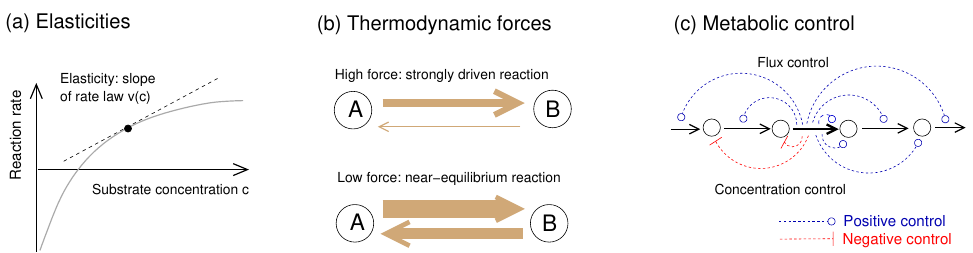
Figure 1. Metabolic rate laws and dynamics: elasticities, thermodynamic forces, and metabolic control. ( a ) A reaction rate depends on metabolite concentrations as described by a rate law v ( e , c ) . The slope ∂ v / ∂ c is called reaction elasticity. ( b ) In strongly driven reactions, with a driving force (cid:29) 1, the net rate is dominated by the forward rate and the product elasticity is almost θ = ln v + v − zero. In contrast, close to chemical equilibrium (with a driving force θ ≈ 0 and large forward and ∂ v l = c i backward rates, but a small net rate), the scaled elasticities ˆE v l c are large. ( c ) Metabolic v l ∂ c i i control coefficients describe how perturbations in single reactions shape steady-state fluxes and metabolite concentrations across the network. If an enzyme is inhibited or repressed, upstream metabolites accumulate and downstream metabolites deplete. The details of this response depend on network structure, flux distribution, and reaction elasticities. Thermodynamic forces shape metabolic control via the elasticities: a strongly driven reaction, with its low product elasticity, is insensitive to downstream processes and deprives all downstream enzymes of their flux